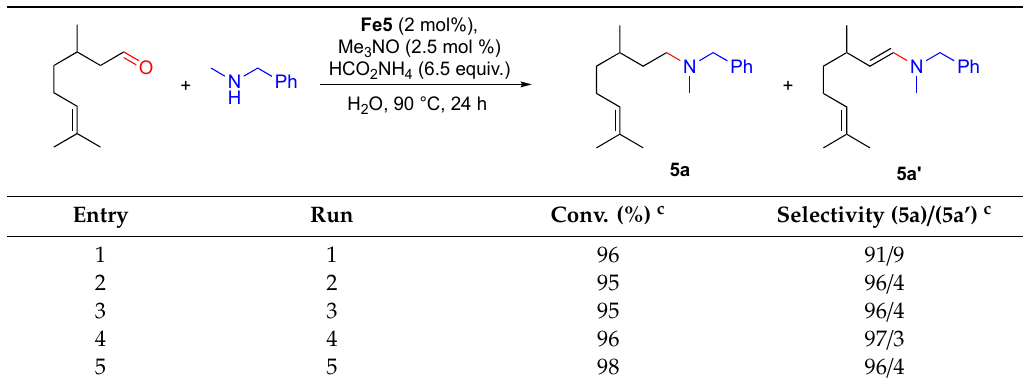
Table 5. Recycling of the pre-catalyst Fe5 a,b .